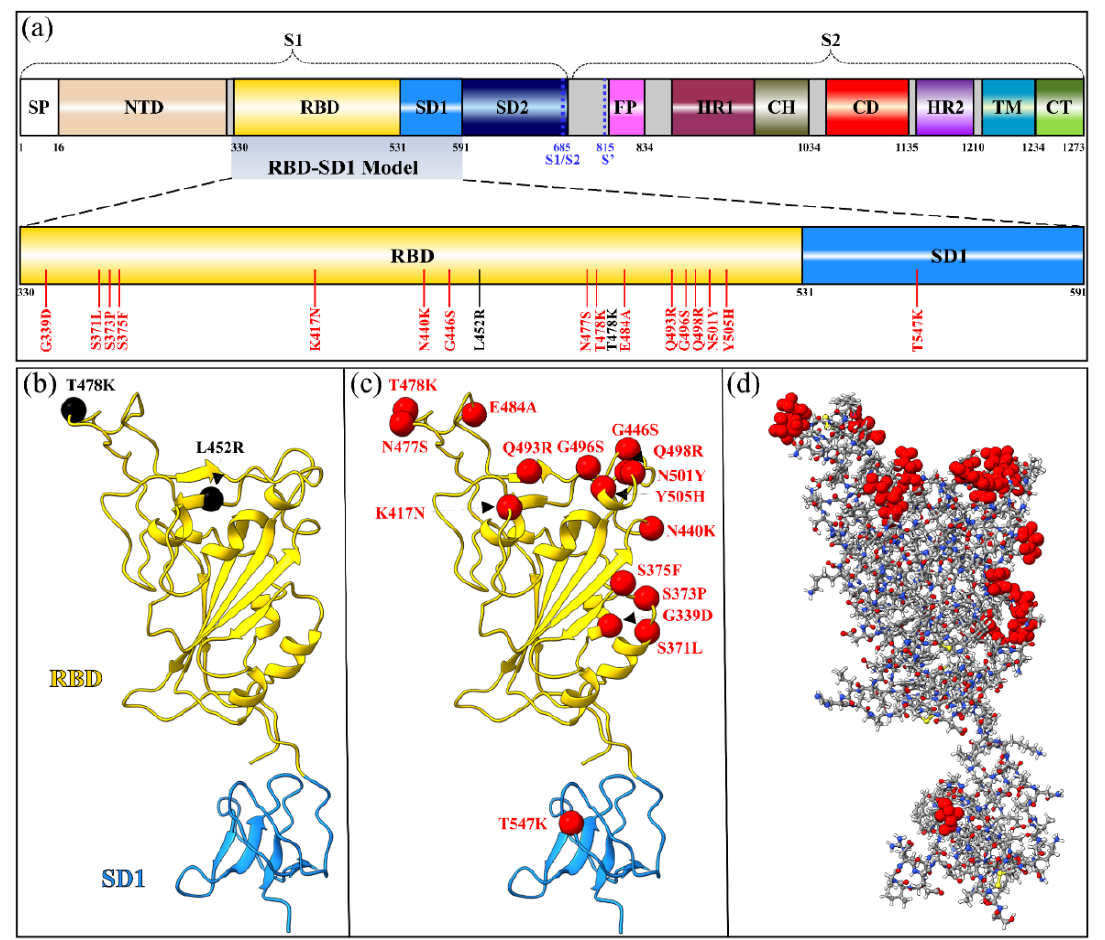
Figure 12. RBD-SD1 models in both Delta and Omicron variants. ( a ) Schematic depiction of S-protein primary structure divided into domains with cleavage sites S1/S2 and S2’. The RBD-SD1 regions with all their DV and OV mutations are highlighted and zoomed in. ( b ) The ribbon structure of RBD-SD1 model of DV with two mutations marked by the black circles. ( c ) The RBD-SD1 model of BA.1 OV with 16 mutations marked by the red circles. ( d ) The ball and stick model in ( c ) with 16 OV mutations marked by the red circles.